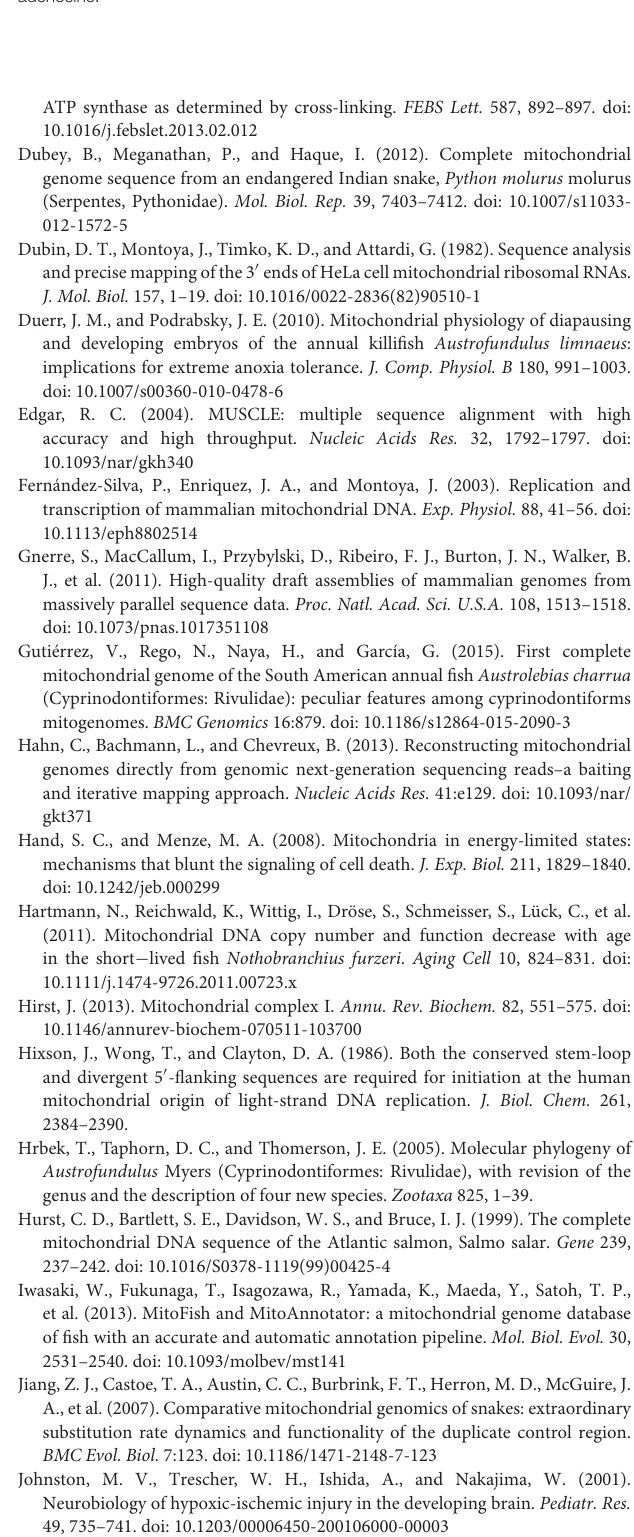
refer to the first, second, and third sites that mapped as non-reference